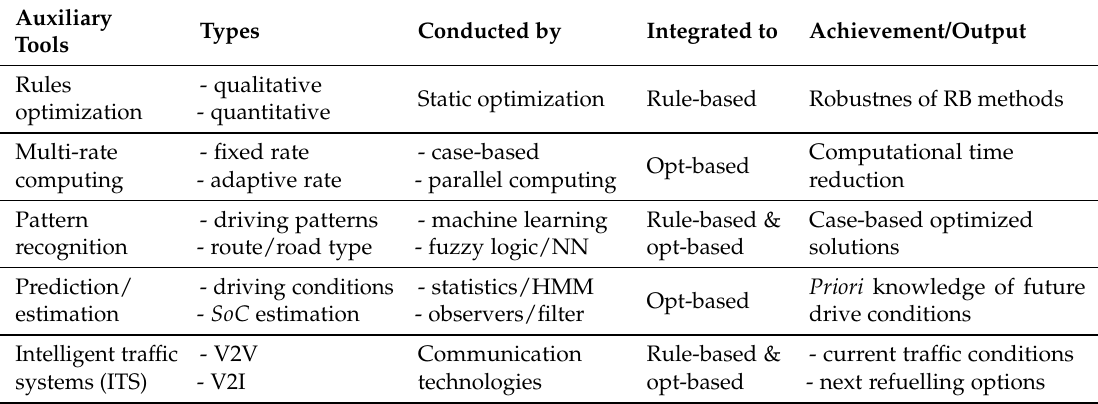
Table 1. Characteristic of implemented subsidiary tools in real-time optimization-based